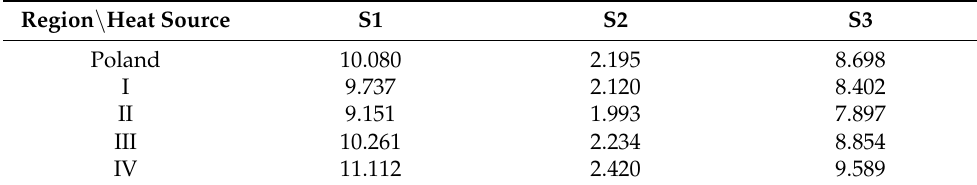
Table 7. Annual ecological heating costs G E [(Pt · K)/(W · year)].